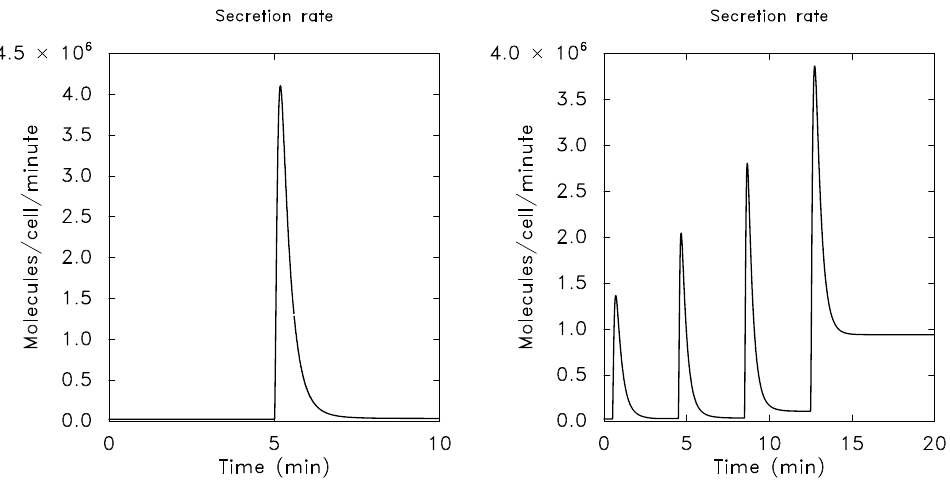
Figure 1. Two examples of the response of an adapting system to changes in the stimulus level. We show the predicted cyclic AMP (cAMP) relay response, as measured by the secreted cAMP, to extracellular cAMP stimuli in the cellular slime mold Dictyostelium discoideum . Left: A step change in extracellular cAMP from 0 to 10 − 8 M elicits a single pulse of secreted cAMP. Right: The system responds and adapts to a sequence of step increases ranging from 10 − 9 M to 10 − 6 M, but at the highest stimulus the transduction system saturates. (From [1], with